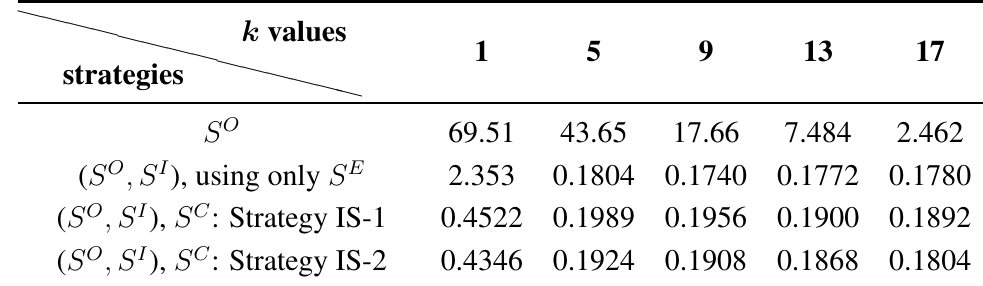
Table 2. The k -nearest neighbor ( k -NN) error rates (%) of using the S O feature only and using two-dimensional features, i.e ., ( S I , S O ), respectively. S E is calculated by Strategy IS-2, and S O is calculated by Strategy